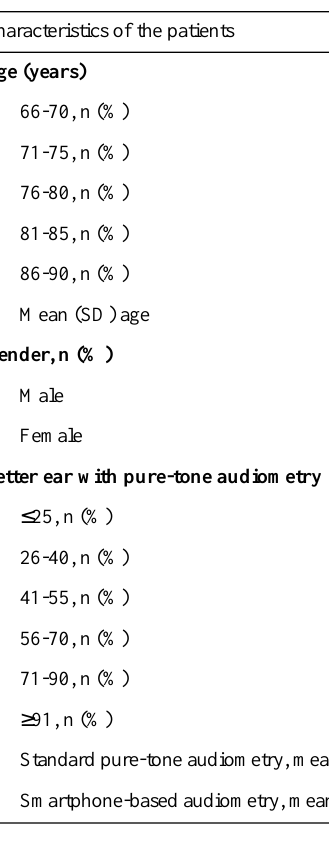
Table 1. Demographic data of the patients